Question: Describe this figure in one sentence.
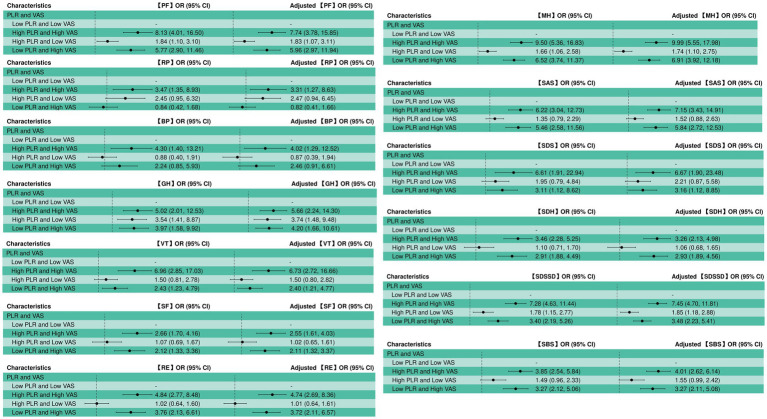
Answer: Logistic regression analysis of the combined PLR and VAS indicators versus the SPP indicator.